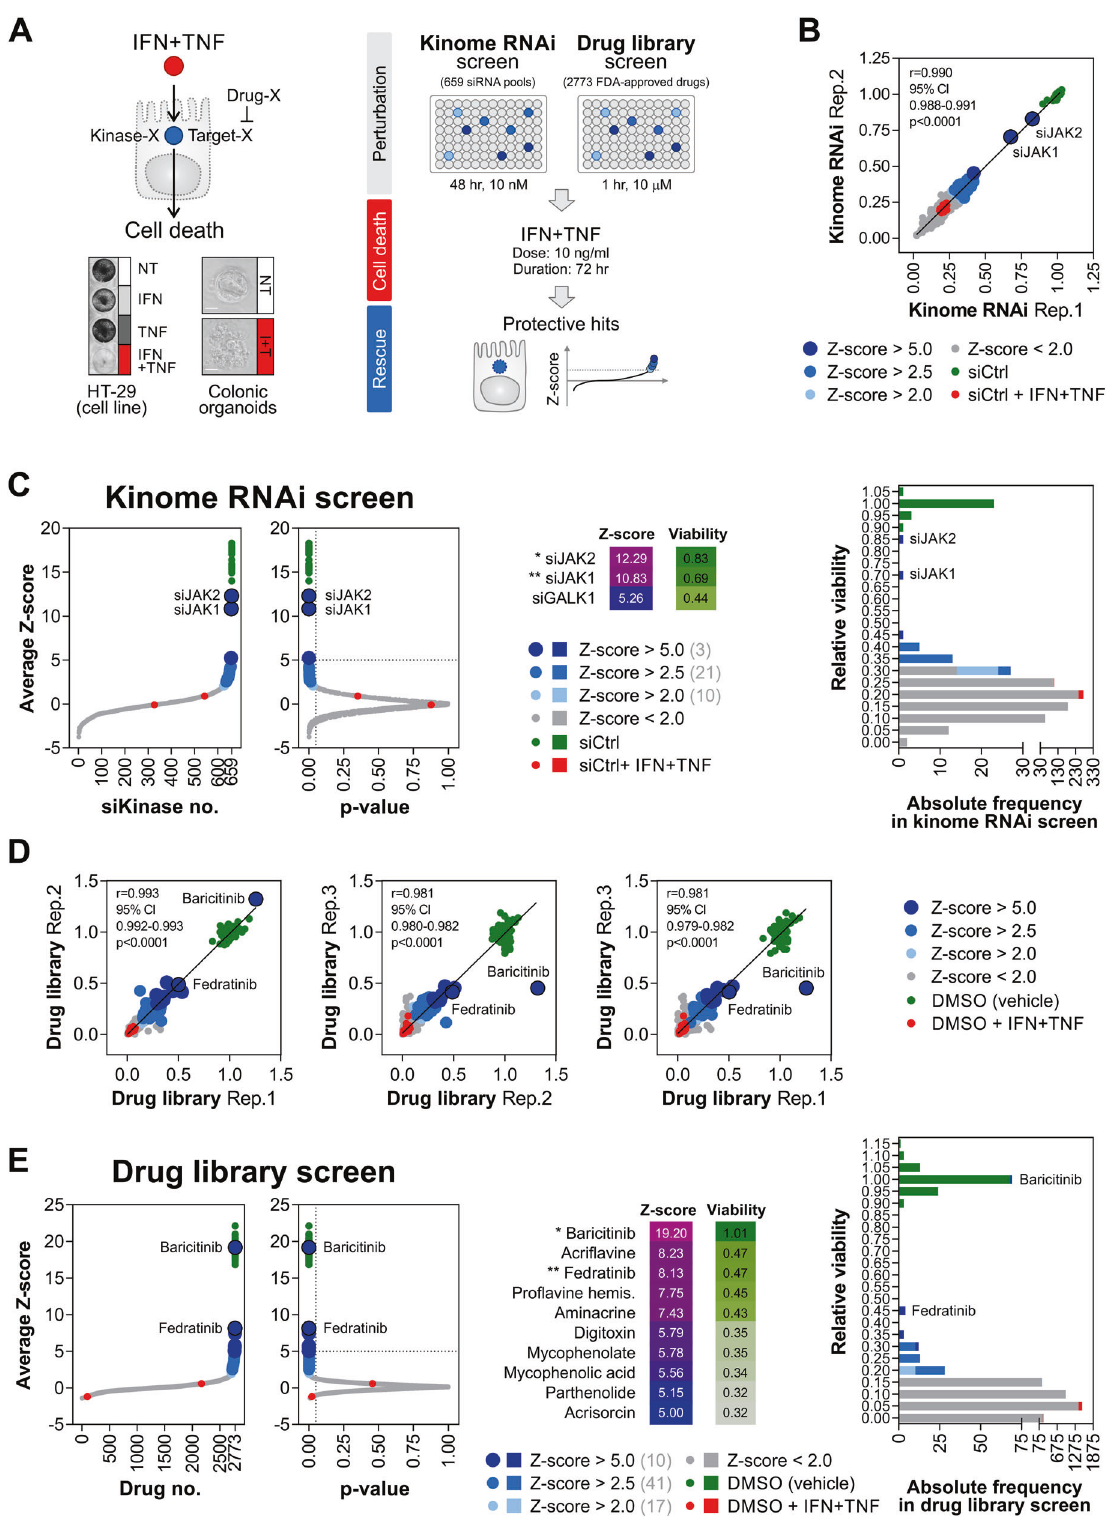
Fig. 2 Functional screening identi fi es JAK1/2 as key drivers of IEC death induced by IFN- γ /TNF- α . A Schematic work fl ow of the kinome RNAi and drug library rescue screens performed in HT-29 cells against a fi xed cell death trigger: IFN- γ /TNF- α , 72 h, 10 ng/ml each. B Interreplicate reproducibility in the kinome RNAi screen. C Z -score distribution and its associated p values across the kinome RNAi library (left). Average relative viability for candidate genes with Z -score >5.0 (middle). Frequency distribution of average relative viability across the kinome RNAi library (right). D Interreplicate reproducibility in the drug library screen. E Z -score distribution and its associated p values across the drug library (left). Average relative viability for candidate drugs with Z -score >5.0 (middle). Frequency distribution of average relative viability across the drug library